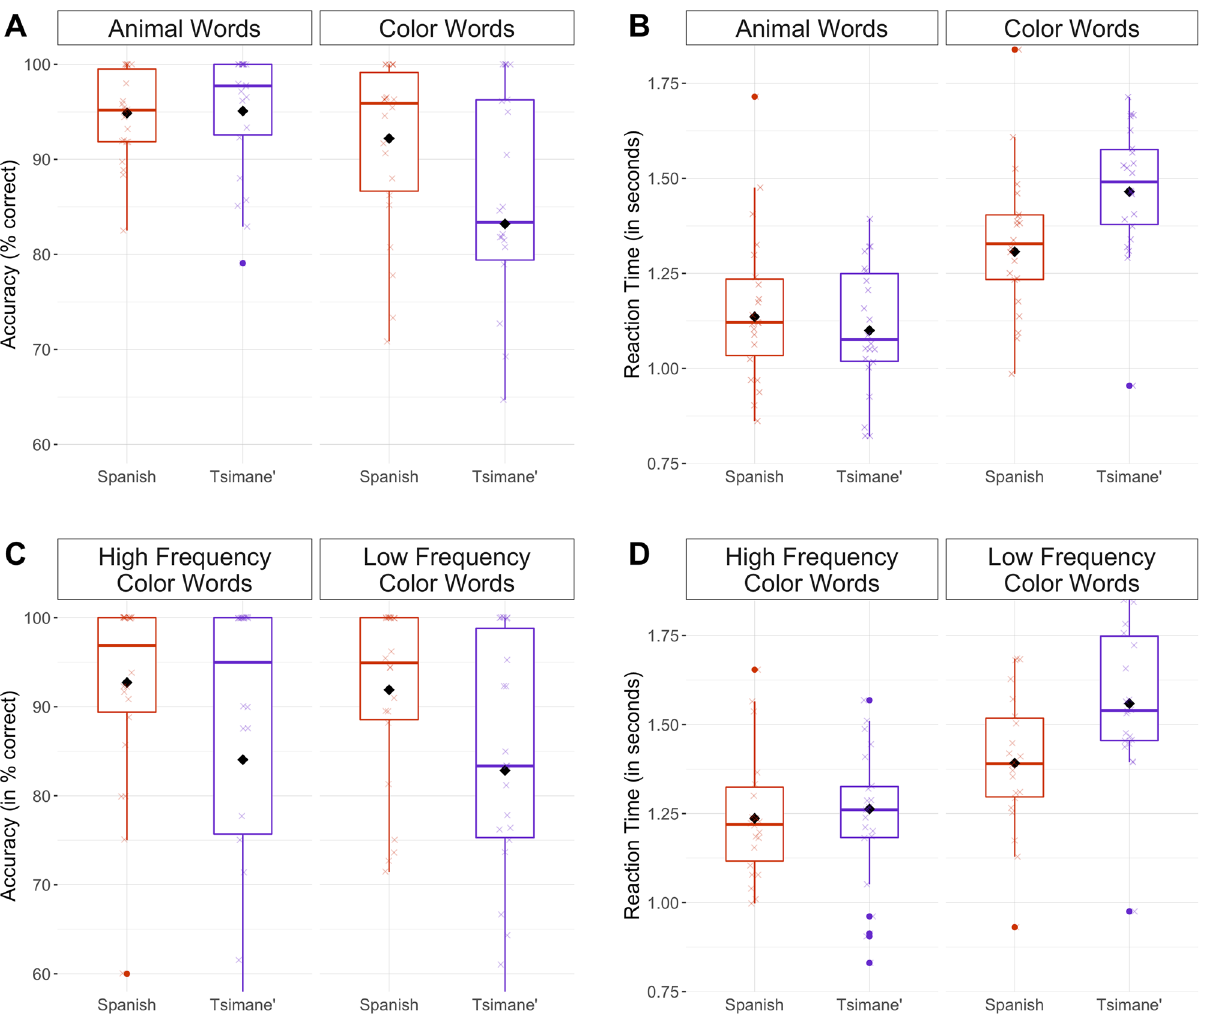
Figure 2. Tsimane’–Spanish bilinguals are faster at naming color words in Spanish than Tsimane’, but only for low frequency color words. Figures depict accuracy ( A ) and reaction time ( B ) data in naming animal and color words in Tsimane’ and Spanish, and accuracy ( C ) and reaction time ( D ) data in naming high and low frequency color words in Tsimane’ and Spanish. In all subpanels, boxplot figures include median, interquartile range, standard deviation and outlier values (solid dots) for responses to each word-type in the Tsimane’–Spanish bilinguals’ two languages. The average response of each individual is depicted as crosses, jittered for visualization purposes. The mean average response across all speakers is depicted as a solid black